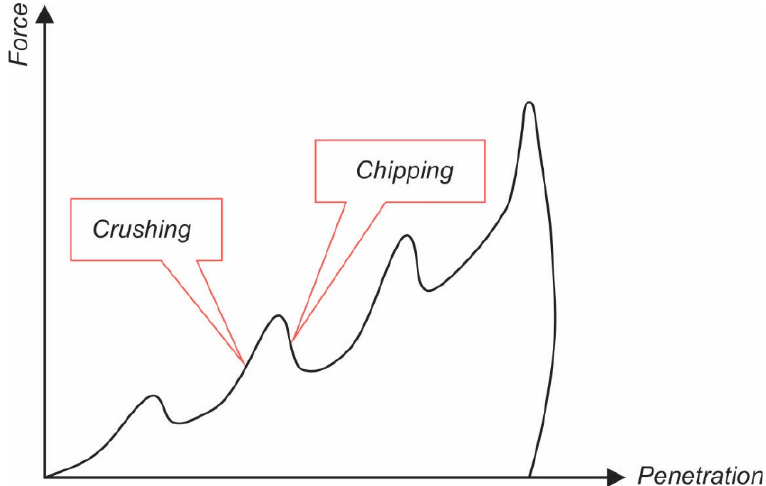
Figure 1. Progressing of the tooth of the roller cone bit through the crushing and chipping phases [40,41]. Positive slopes show elastic deformations or collapse, while negative slopes show crushing.